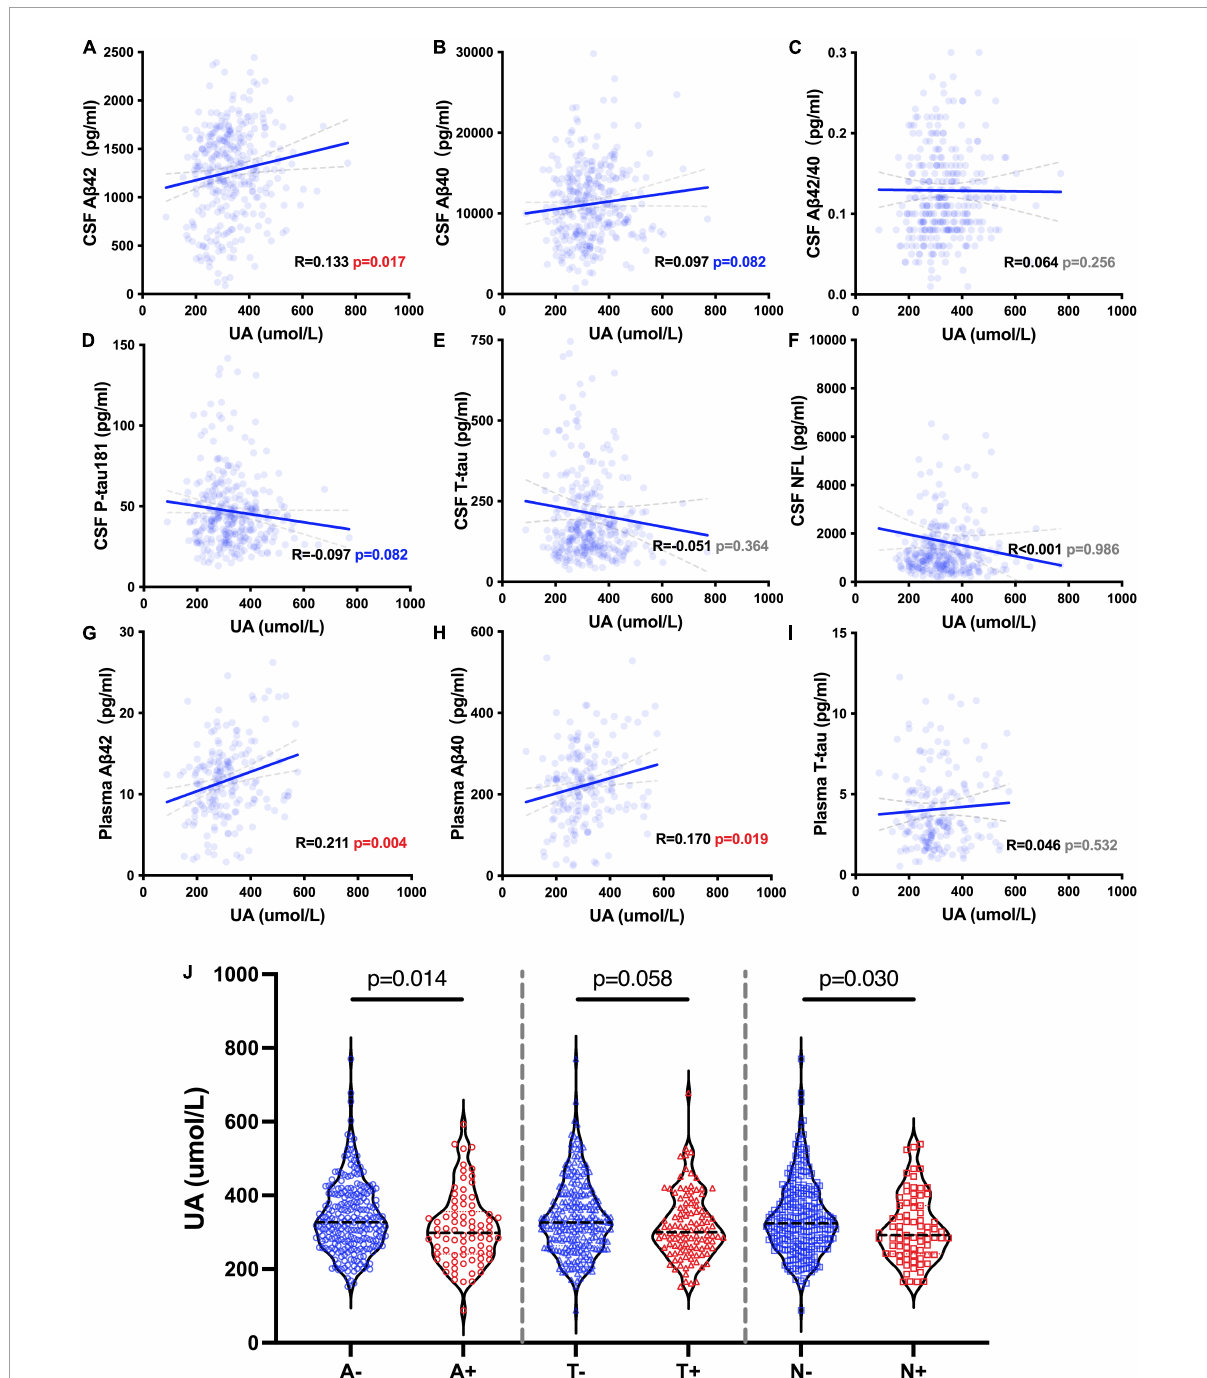
FIGURE4 UA-related ATN biomarkers. (A–I) Spearman’s correlation analysis between the levels of sUA and ATN biomarkers. (J) Mann–Whitney U test between groups according to the cut-offs of CSF ATN biomarkers, including A– and A +, T– and T + and N– and N +.